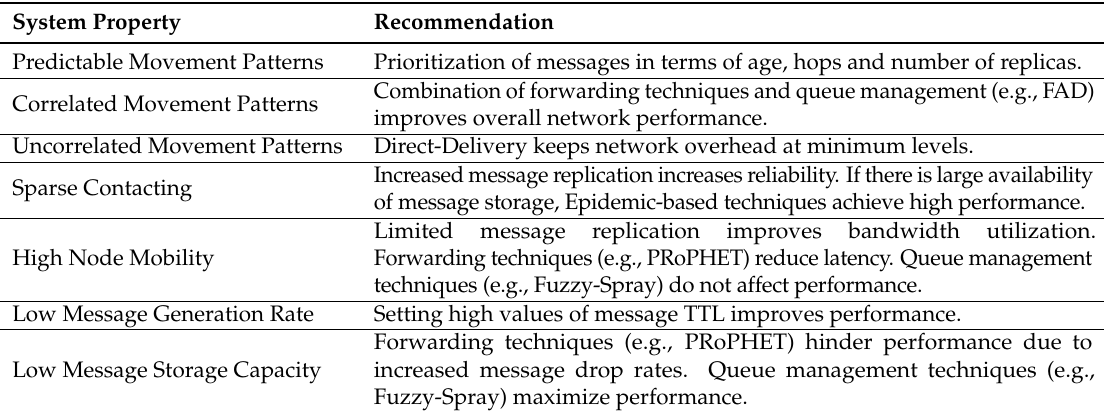
Table 4. Synopsis of technical